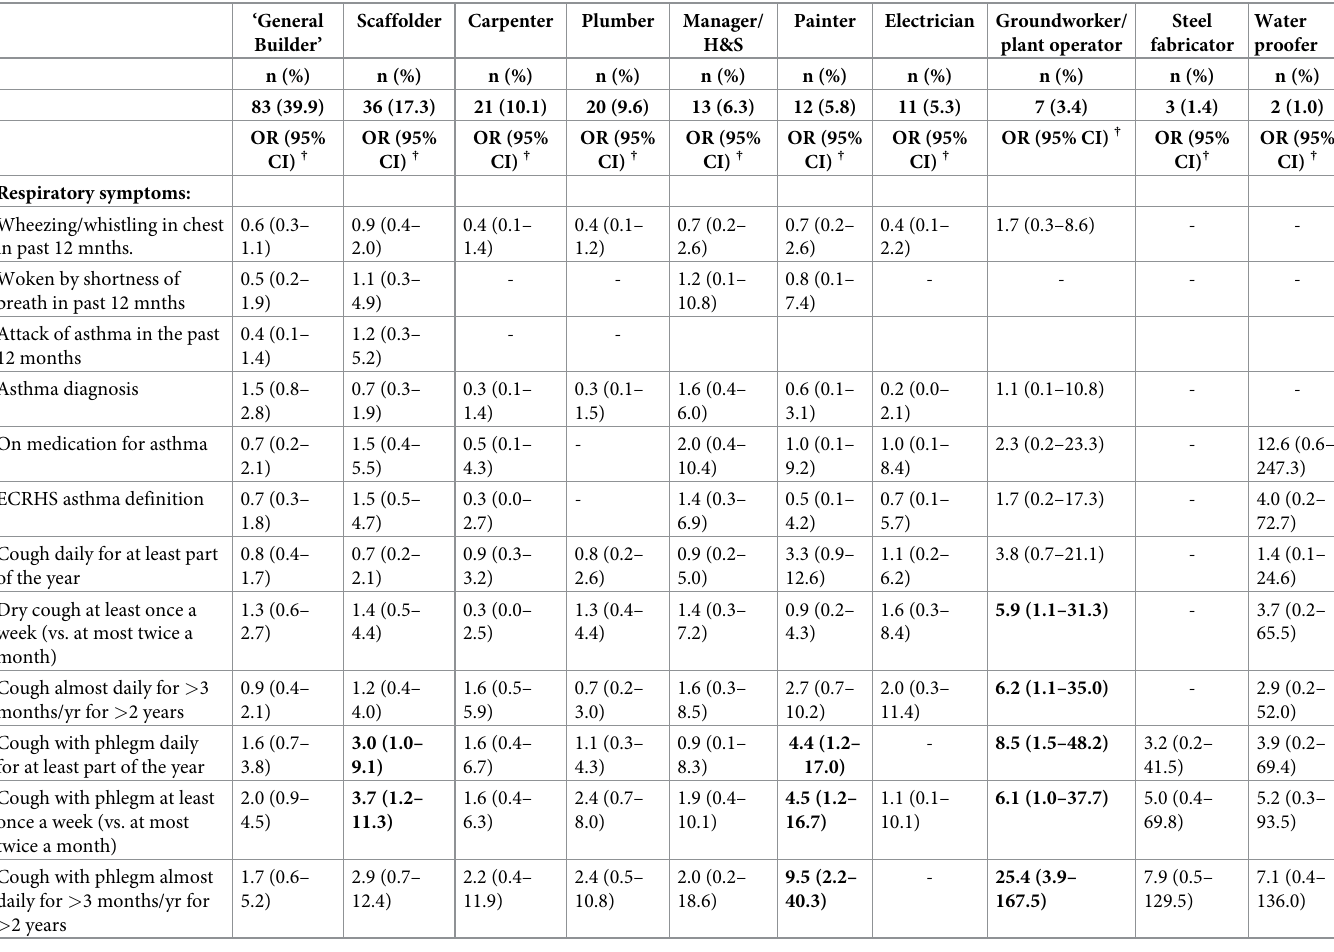
Table 3. Prevalence odds ratios of respiratory symptoms in individual construction trades compared to reference workers (n =